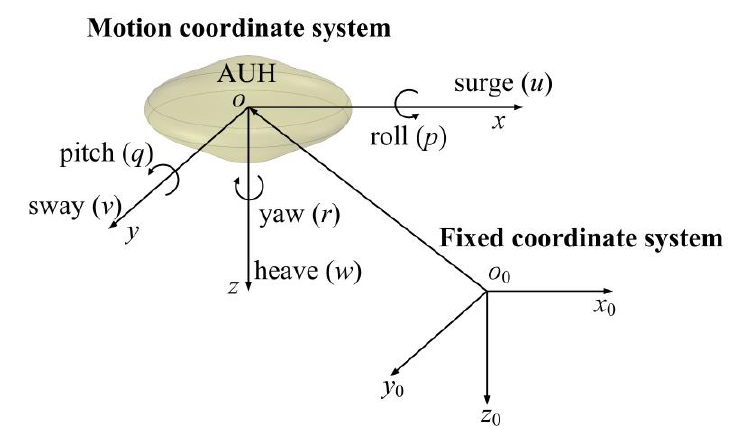
Figure 3. Coordinate system